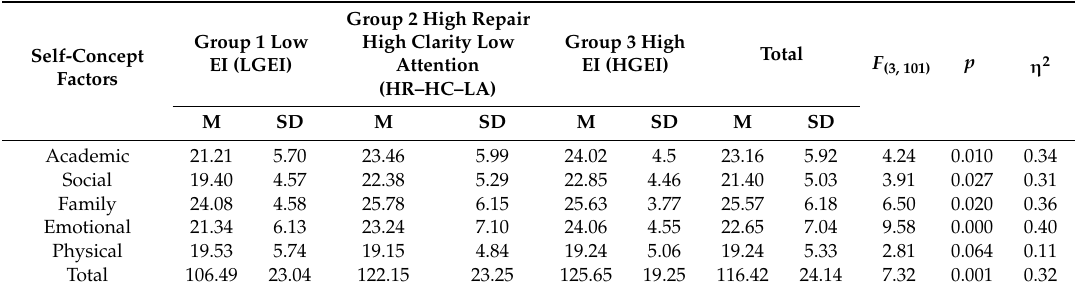
Table 2. Di ff erences between groups in self-concept Table 2. Differences between groups in self-concept dimensions.